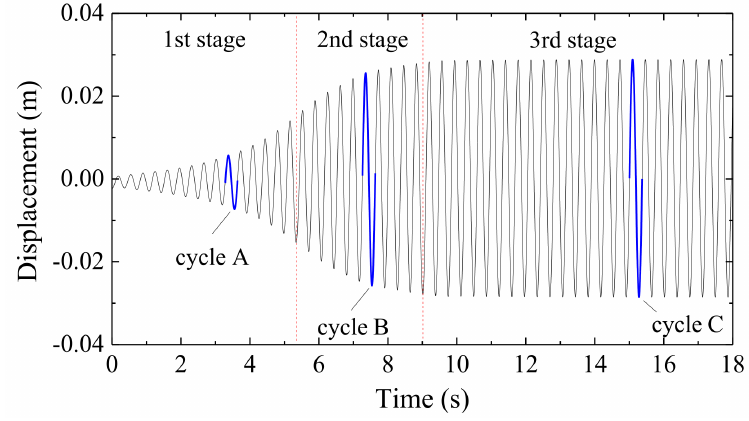
Figure 3. Vertical displacement response and stage division of